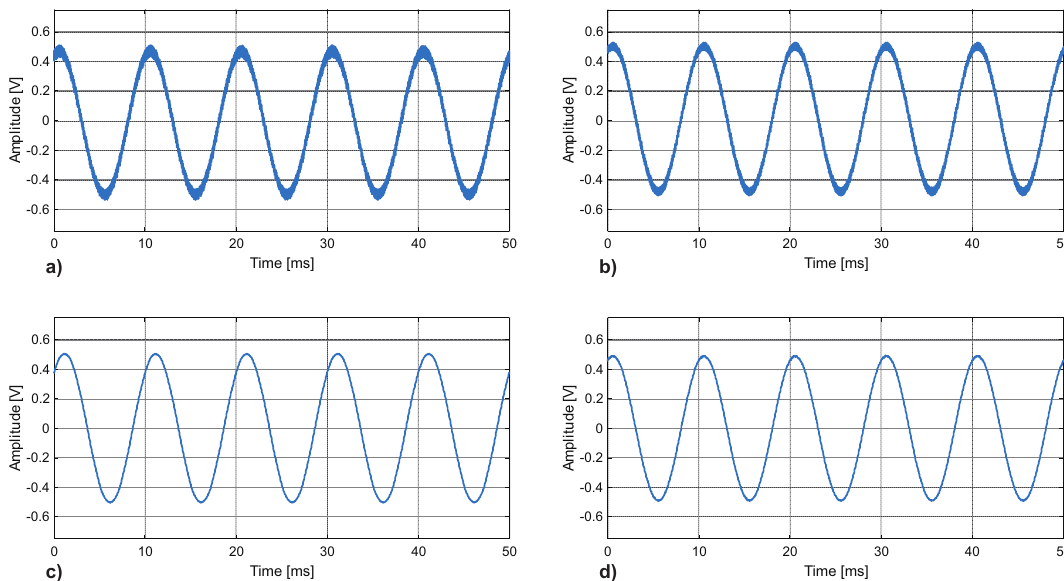
Figure 15. Time-domain waveform of the acquired signals under a damped exponential modulated EMI: ( a ) OPA2277 opamp output voltage with EMI injection; ( b ) MCP6V02 opamp output voltage with EMI injection; ( c ) nominal input signal spectrum as in Figure 8b; ( d ) Output voltage with EMI injection estimated starting from the EMI corrupted waveforms in ( a , b ), by the proposed EMI-induced errors suppression procedure with α = 0.445.